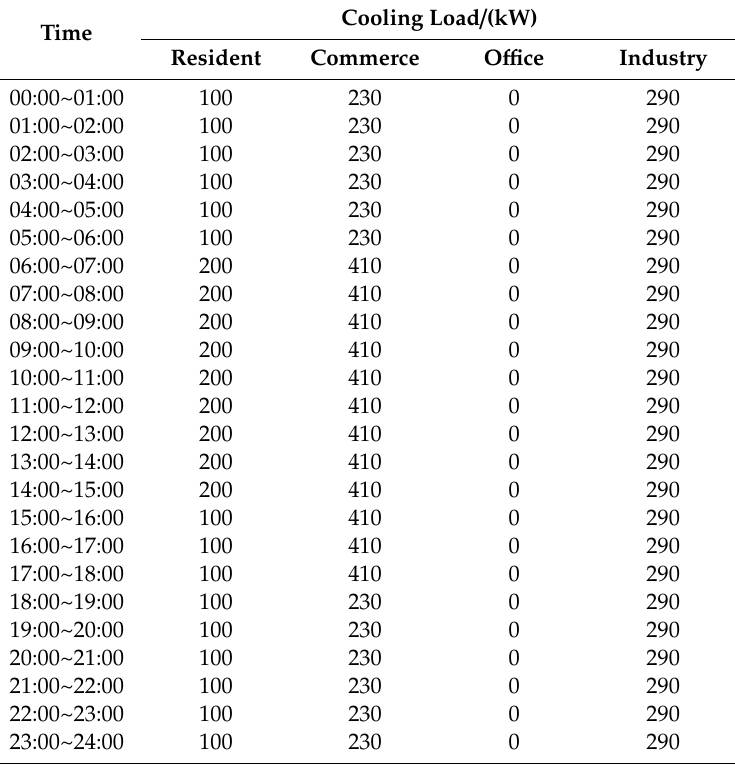
Table A4. Cooling